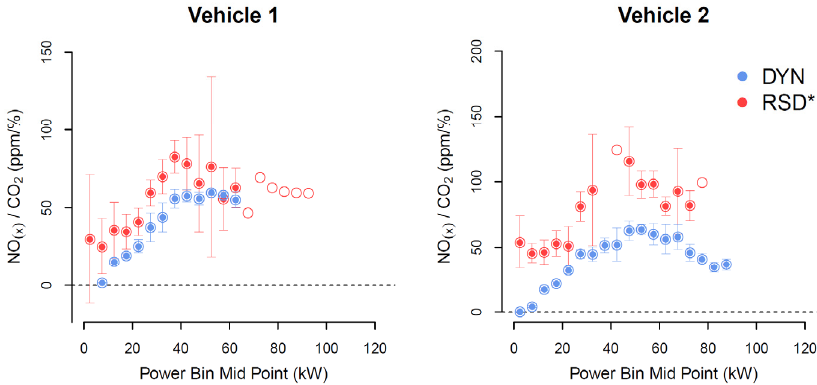
Figure 11. Mean hot running emission ratios versus power, including 95% confidence intervals. The open dot points represent data with a single observation.